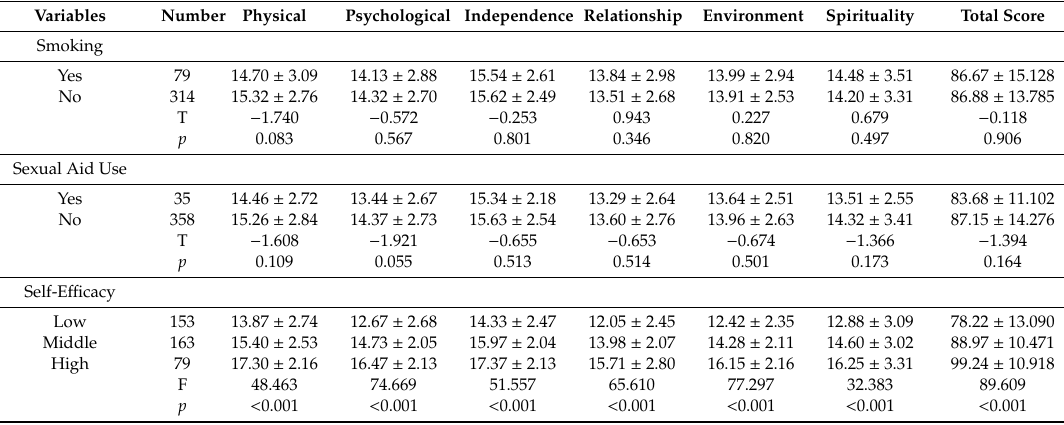
Table 5. Psychosocial factors and their associations with quality of life ( n = 395).